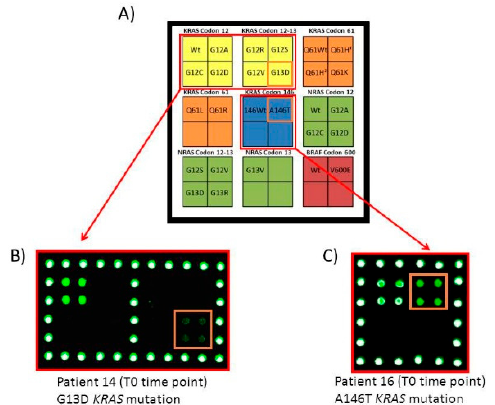
Figure 2. Microarray analysis of ctDNA extracted from plasma of patient 14 and 16 at T0 time point. ( A ) Schematic representation of the spotted barcode probe array. Each position in the grid identifies an individual barcode probe address corresponding to KRAS codon 12-13, KRAS codon 61 (Q61H1 c.183A>C, Q61H2 c.183A>T), KRAS codon 146, NRAS codon 12-13 and BRAF mutations. Silicon chips coated with copoly(DMA-NAS-MAPS) are used as substrates for the covalent attachment of amino-modified barcode probe oligonucleotides arrayed at discrete locations. The white portion of the array is spotted with an amino-modified oligonucleotide (COCU8), not correlated with the genes, to be used as reference spots. ( B ) Microarray scanning of the Cy3 fluorescence signal of the analysis of ctDNA extracted from plasma of patient 14 at T0 time point. Only the part of the array corresponding to the barcode probes for KRAS codon 12 and 13 is shown. The robotically spotted array is hybridized with an individual single strand PCR incubated with the whole set of dual-domain reporters. The fluorescence detection is obtained incubating the array with a mixture of the universal Cy3 labelled oligonucleotide complementary to the tagged-reverse primer of the single strand PCR and with a Cy3-labeled oligonucleotide (COCU10) complementary to COCU8. The barcode probes corresponding to KRAS G13D is highlighted. ( C ) Microarray scanning of the Cy3 fluorescence signal of the analysis of ctDNA extracted from plasma of patient 16 at T0 time point. Only the part of the array corresponding to the barcode probes for KRAS codon 146 is shown. The frame highlights the barcode probes corresponding to the KRAS A146T mutation.